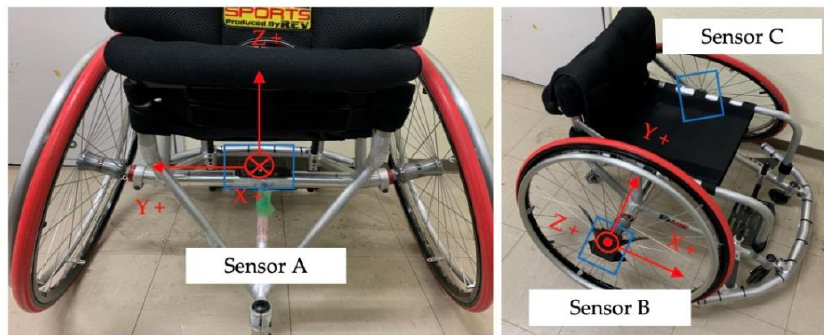
Figure 4. Example of measured camera images.